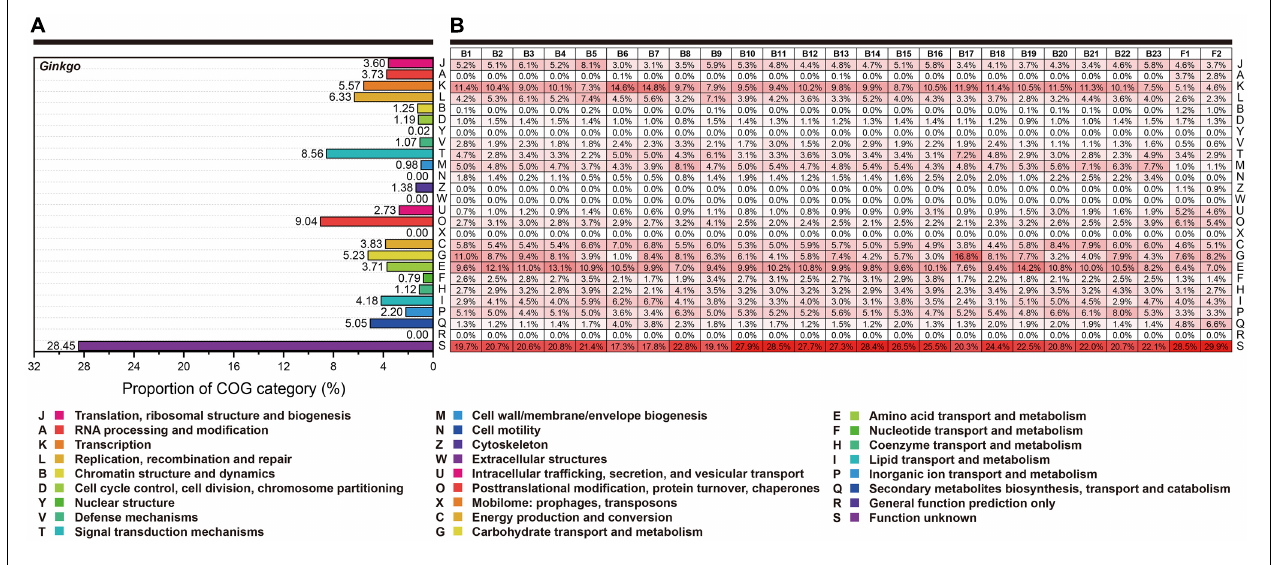
FIGURE 3 | The functional categories based on the COG annotation. Each row represents the same functional classification. (A) The COG categories of Ginkgo biloba genes. (B) The COG categories of genes for all individual strains. The red color density indicated the percentage of genes in this functional category to the total genes annotated in each species’ COG database. At the same time, these percentage values (keep one decimal place) were marked in every square